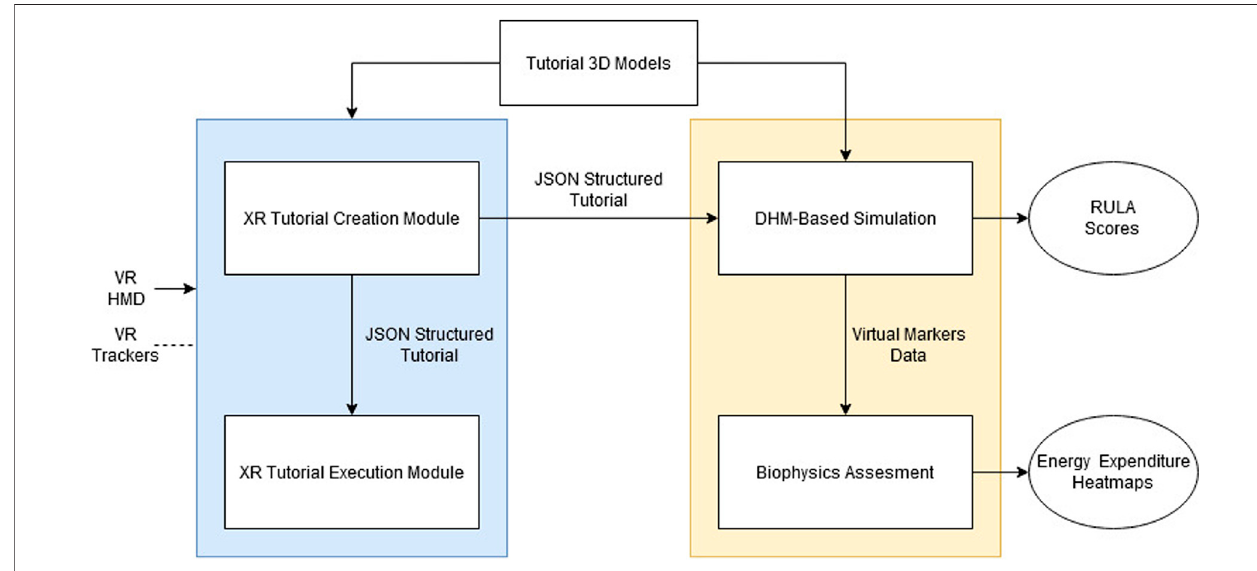
FIGURE 1 | Schematic representation of our XR framework for interactive simulation and ergonomic analysis (XRSISE).